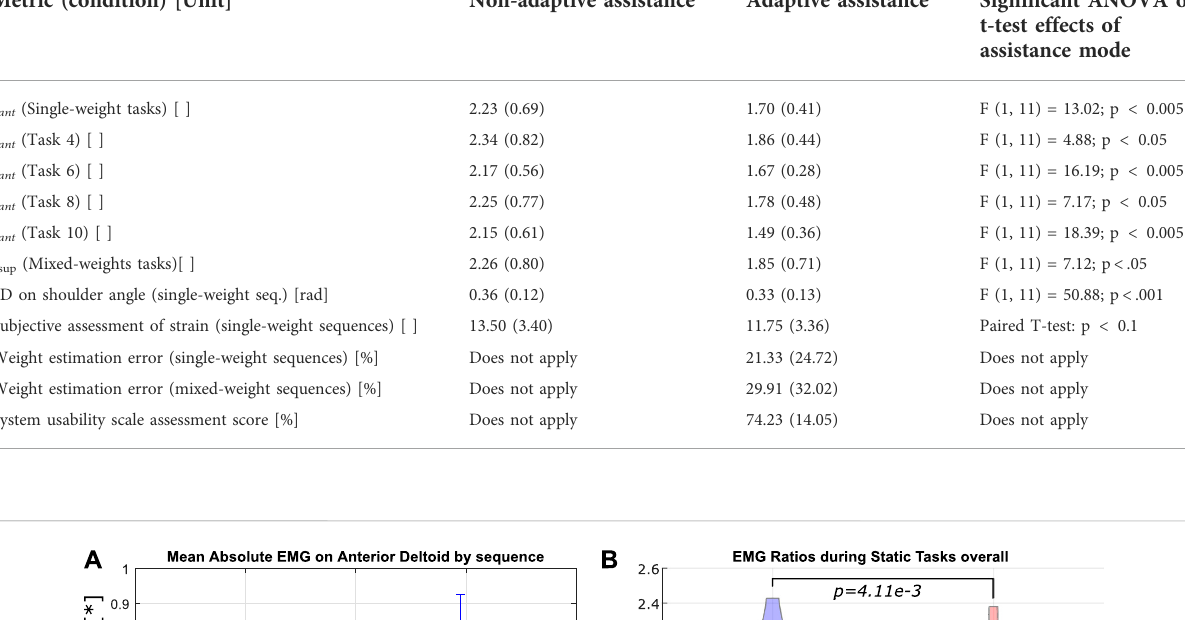
TABLE 1 Overview of the results for all experimental conditions and signi fi cant ANOVA effects were applicable. The metric values are indicated in format mean (standard deviation) . Metric (condition) [Unit]